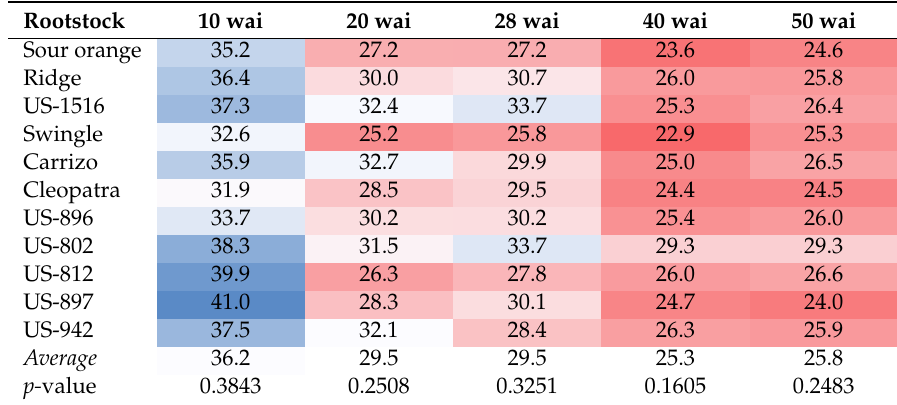
Table 2. Leaf Ct-values of infected plants used for assessment of horticultural parameters. Rootstock